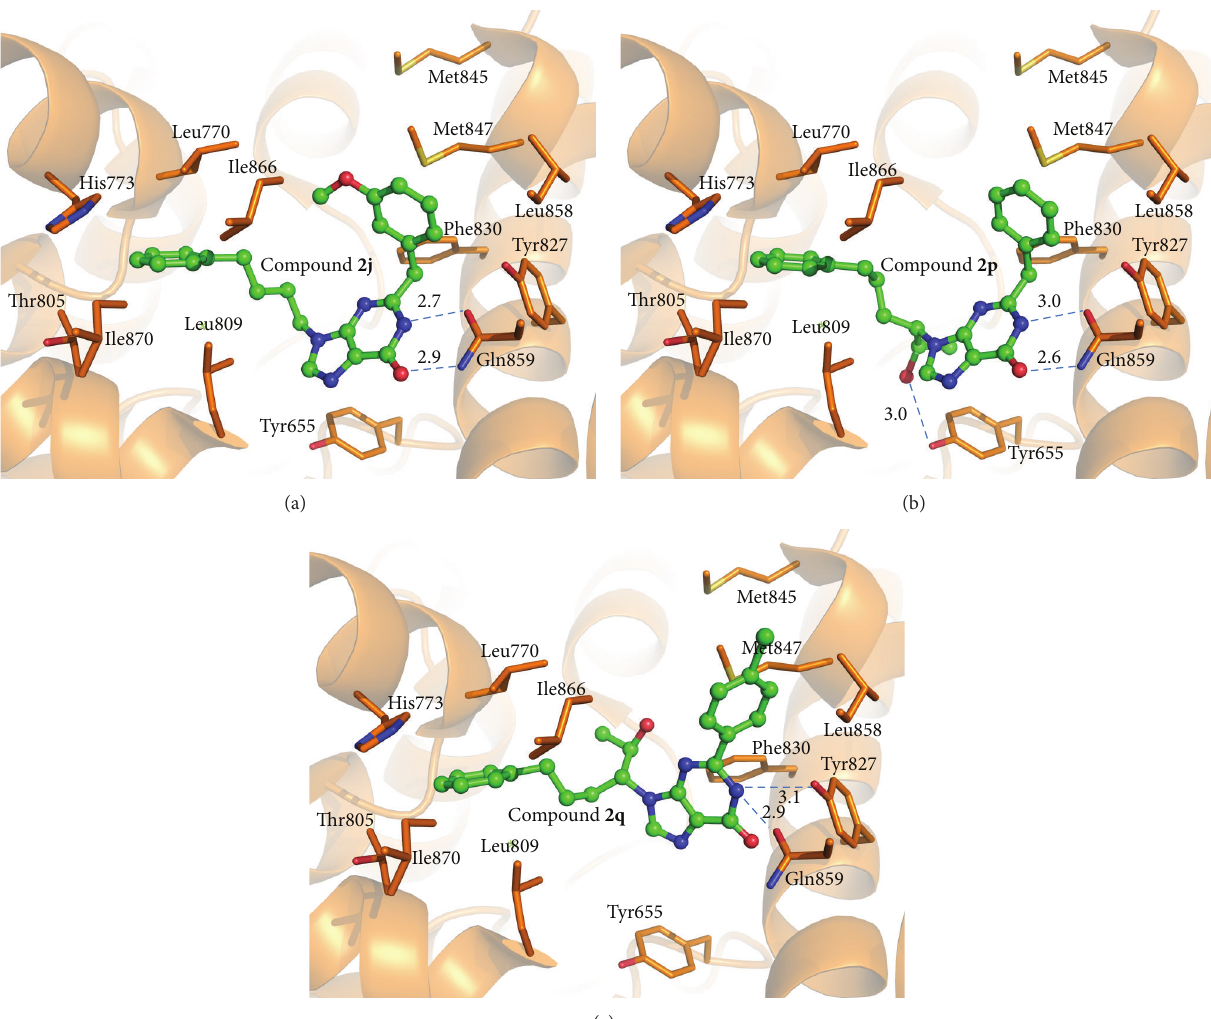
Figure 3: Binding mode of compounds 2j (a), 2p (b), and 2q (c) in the active site pocket of PDE2. Each ligand is rendered as balls and sticks and the surrounding residues are rendered as sticks. For the convenience of display, some residues and atoms are not shown. See Figure 2 for the color codes of the atom